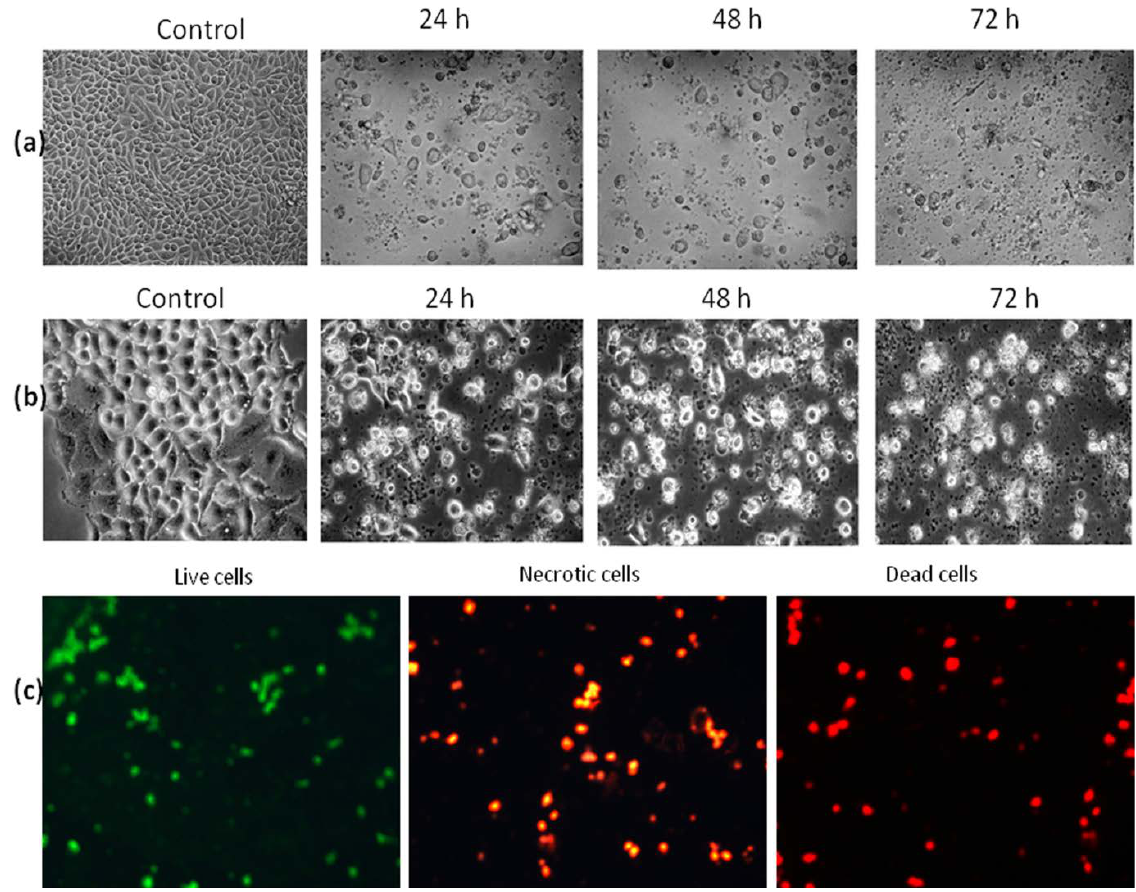
necrotic cells or dead cells ( red